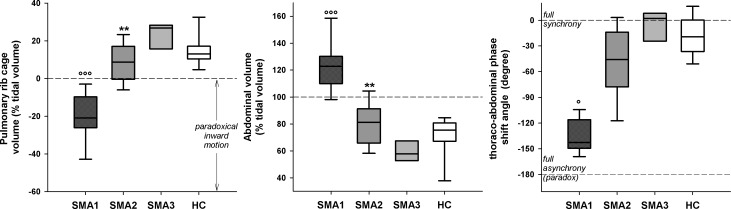
Box-and-whisker plot representing the median (line within the box), the IQR (length of the box), the 90th and the 10th percentiles (whiskers above and below the box) of pulmonary ribcage percentage contribution to tidal volume (left panel), abdominal percentage contribution to tidal volume (middle panel) and thoraco-abdominal phase shift angle (right panel) in SMA types I, II, III and healthy children (SMA1, SMA2, SMA3 and HC, respectively) at rest during spontaneous quiet breathing in supine position.Negative values of pulmonary ribcage percentage contribution to tidal volume indicate paradoxical inward movement of the compartment during inspiration. Phase shift angle varies between 0, when the two compartments are fully in phase, and -180° when one compartment is completely out of phase respect the other with consequent paradoxical movement. °,°°°: p<0.05, 0.001 vs SMA2, SMA3 and HC; **: p<0.01 vs SMA3